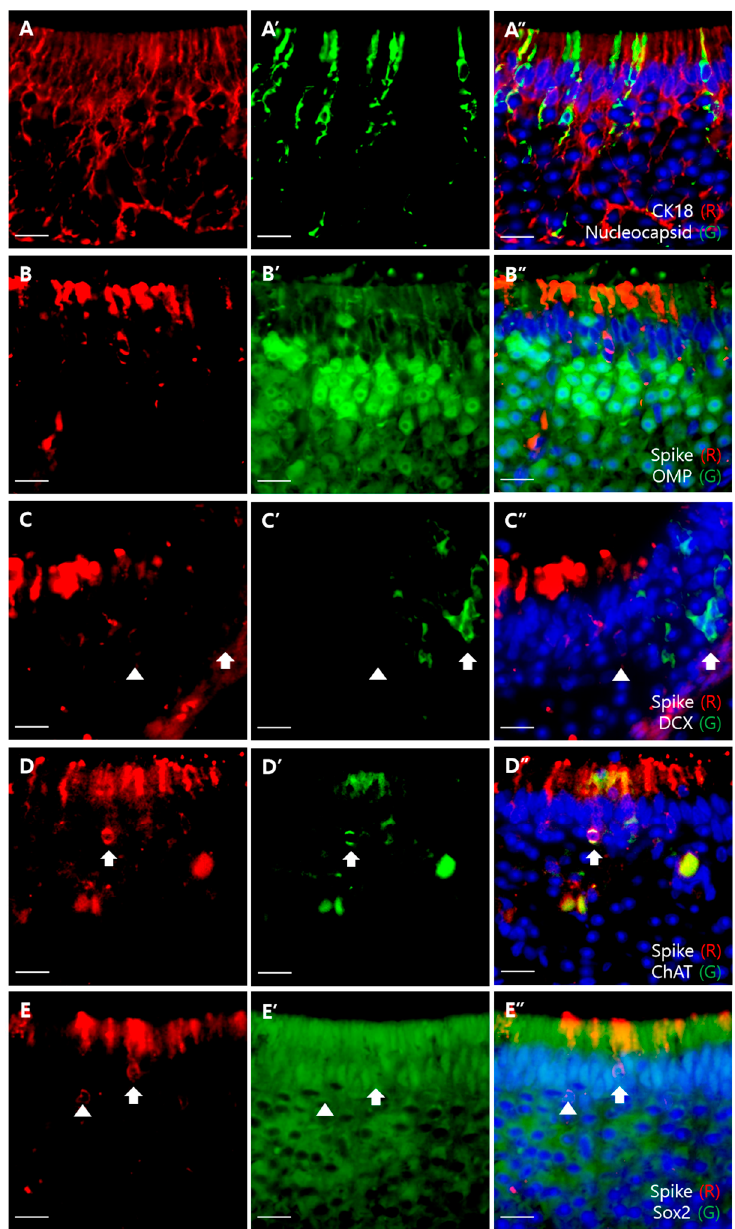
Figure 4. Double immunofluorescent labeling of the VSE. Scale bars = 20 µ m. ( A ) Colocalization of CK18 (red) and nucleocapsid (green). Some CK18-positive cells colocalized with N protein; ( B ) colocalization of the S protein (red) and OMP (green). There was no colocalization between the S protein and OMP; ( C ) colocalization of the S protein (red) and DCX (green). There was no colocalization between the S protein and DCX; ( D ) colocalization of the S protein (red) and ChAT (green) The ChAT-positive cell was colocalized with the S protein; ( E ) colocalization of the S protein (red) and Sox2 (green). The S protein-positive cells encircle Sox2-positive nuclei (arrow), but there are also S protein-positive cells encircling the Sox2-negative nuclei